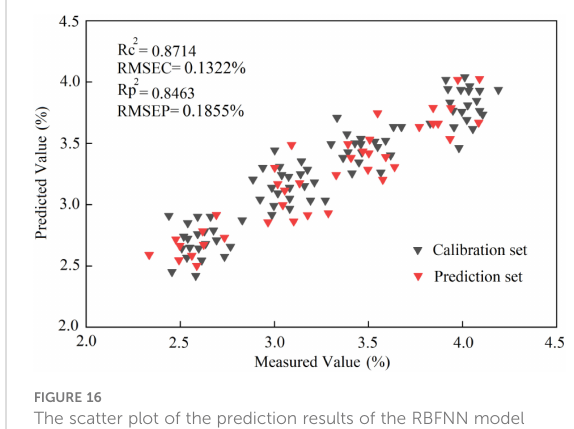
FIGURE 16 The scatter plot of the prediction results of the RBFNN model based on THz spectroscopy.